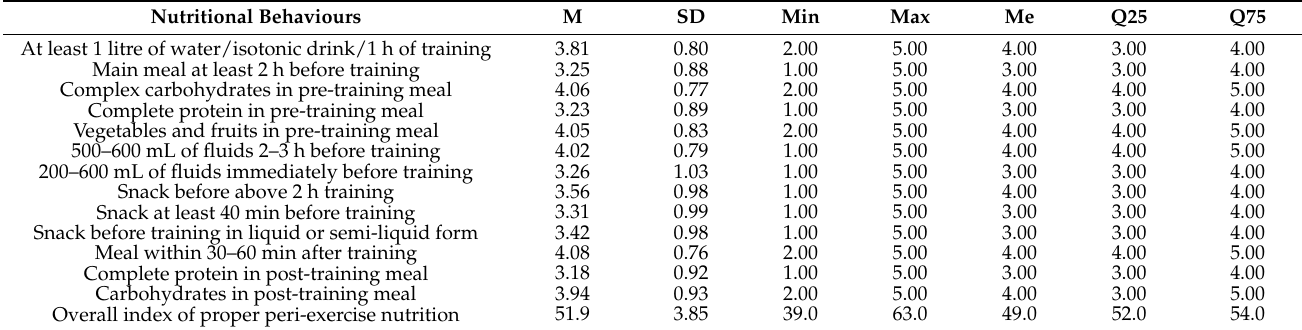
Table 2. Implementing recommendations of peri-exercise nutrition among athletes training team sports (descriptive